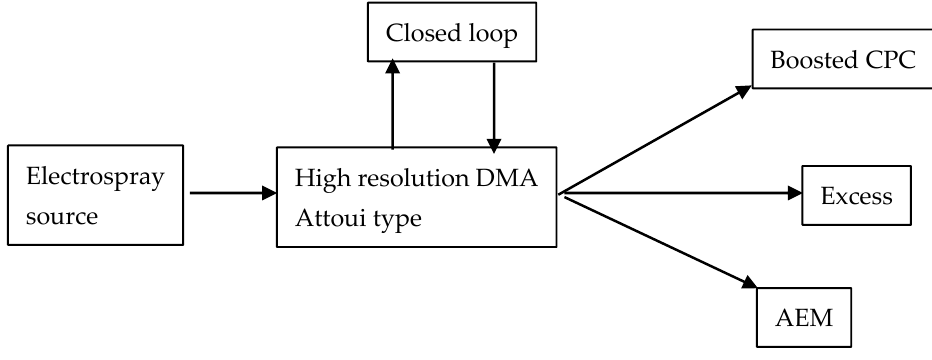
Figure 1. Experimental set up used in this